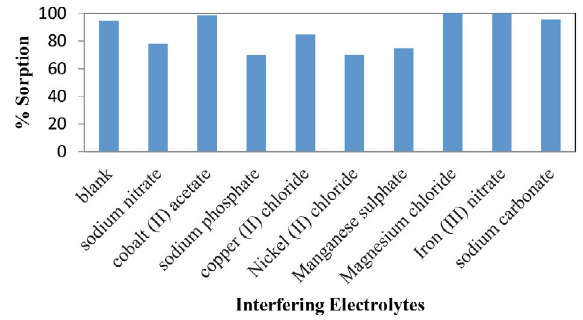
Figure 14. Sorption of Cr(VI) onto isatin based Amberlite XAD-2 resin in the presence of other electrolytes